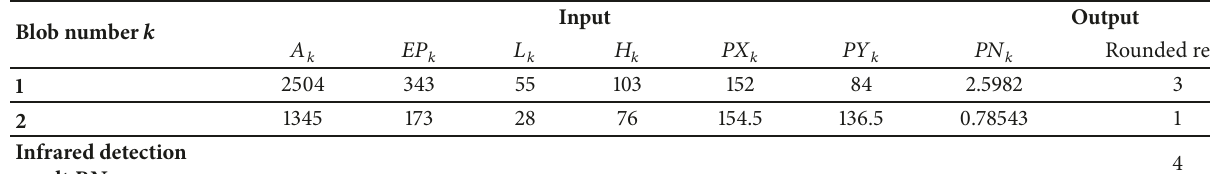
Table 2: Infrared detection results in a daytime scenario.